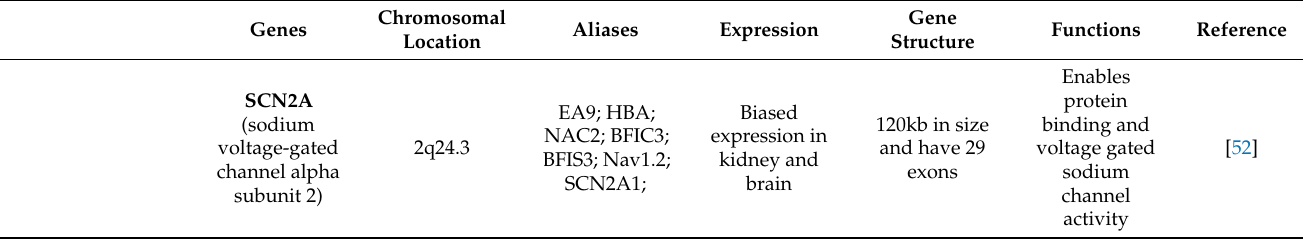
Table 2. Brief description of all the discovered genes based on chromosomal location, aliases, functions, expression, and gene